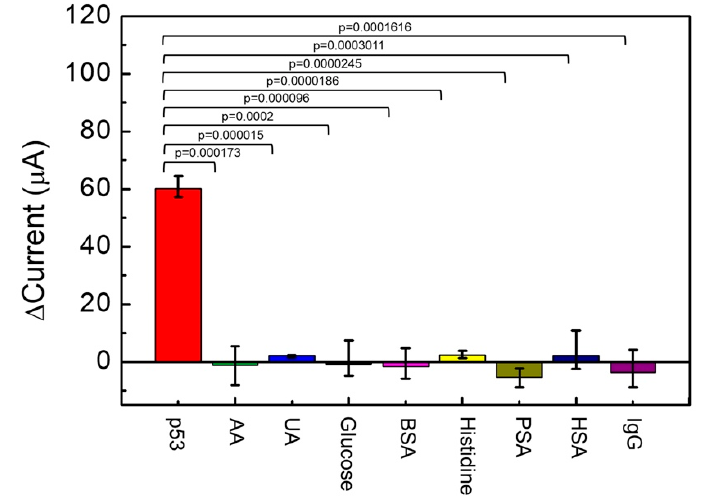
Figure 7. The specificity test on the detection of p53 antigens using the Au/NiPc/anti-p53/BSA electrode with the anti-p53 concentration of 100 ng/mL ( n =